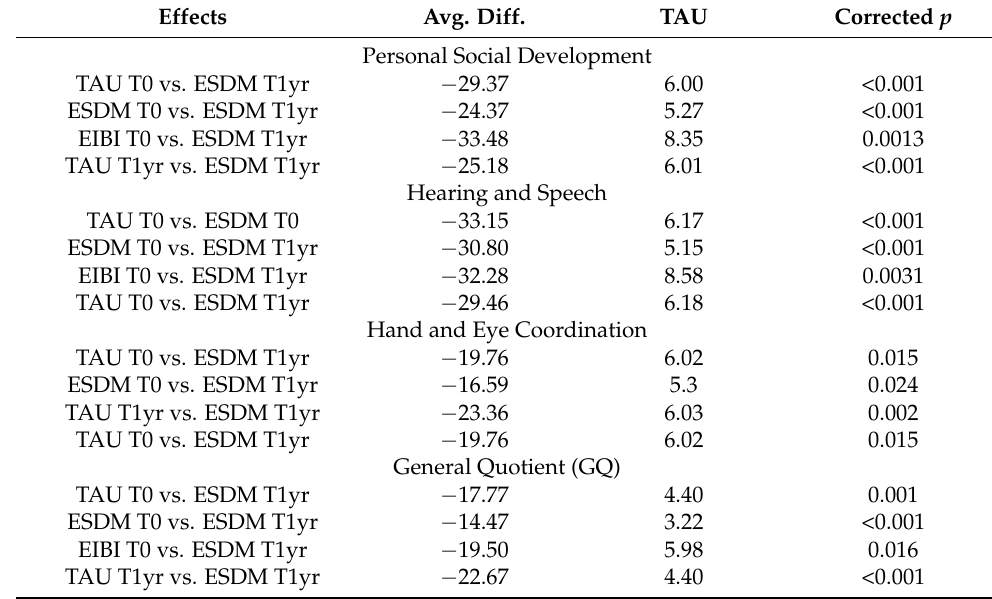
Figure 1. Developmental profile after one year of treatment. Scores in the ( A ) Locomotor Development subscale, ( B ) Hearing and Speech s., ( C ) Performance Test, ( D ) Personal Social Development s., ( E ) Hand and Eye Coordination s. and ( F ) General Quotient scale of the ESDM group, which increased after treatment in comparison to the TAU and EIBI group. * indicate significant differences between groups. Table 2. Significant differences in developmental profile after one year of